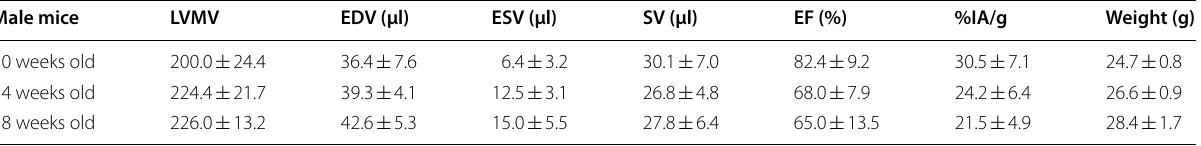
Table 1 Multiparametric longitudinal PET measurements in male